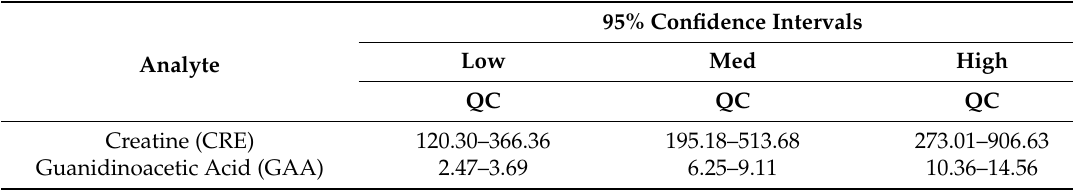
Table 2. 95% confidence intervals of creatine and guanidinoacetic acid using data from three laboratories using the low, medium, and high GAMT QC pools. Units: µ M blood.